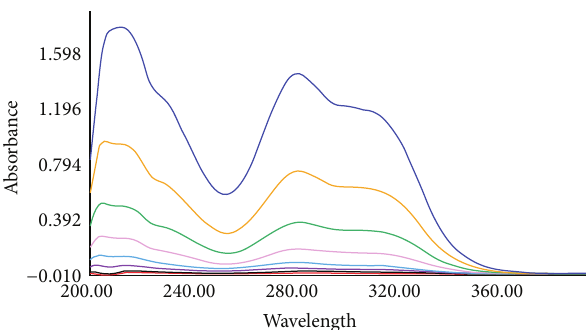
Figure 1: Full spectrum scan of mixed standard substance. (Con- centration increased successively from bottom to top).